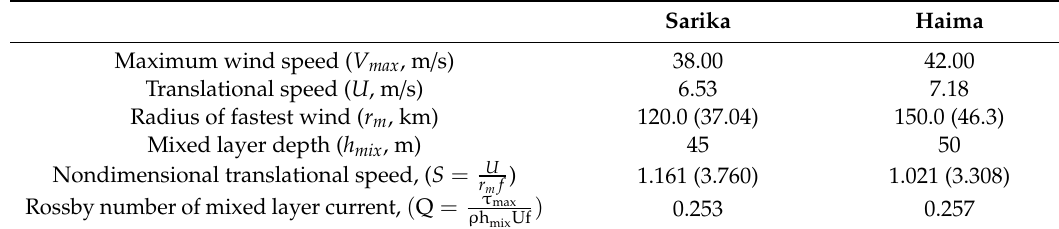
Table 5. Parameters of Typhoons Sarika and Haima